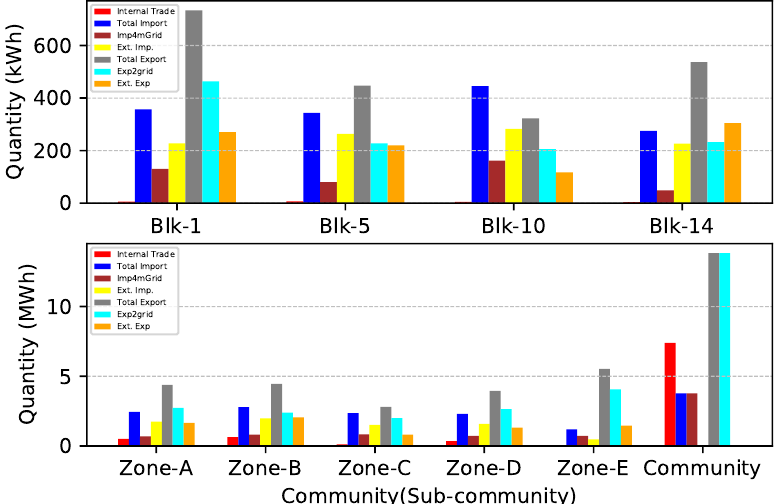
Figure 6. Energy exchange per block ( upper graph ) and zone ( lower graph ) for a single-layer